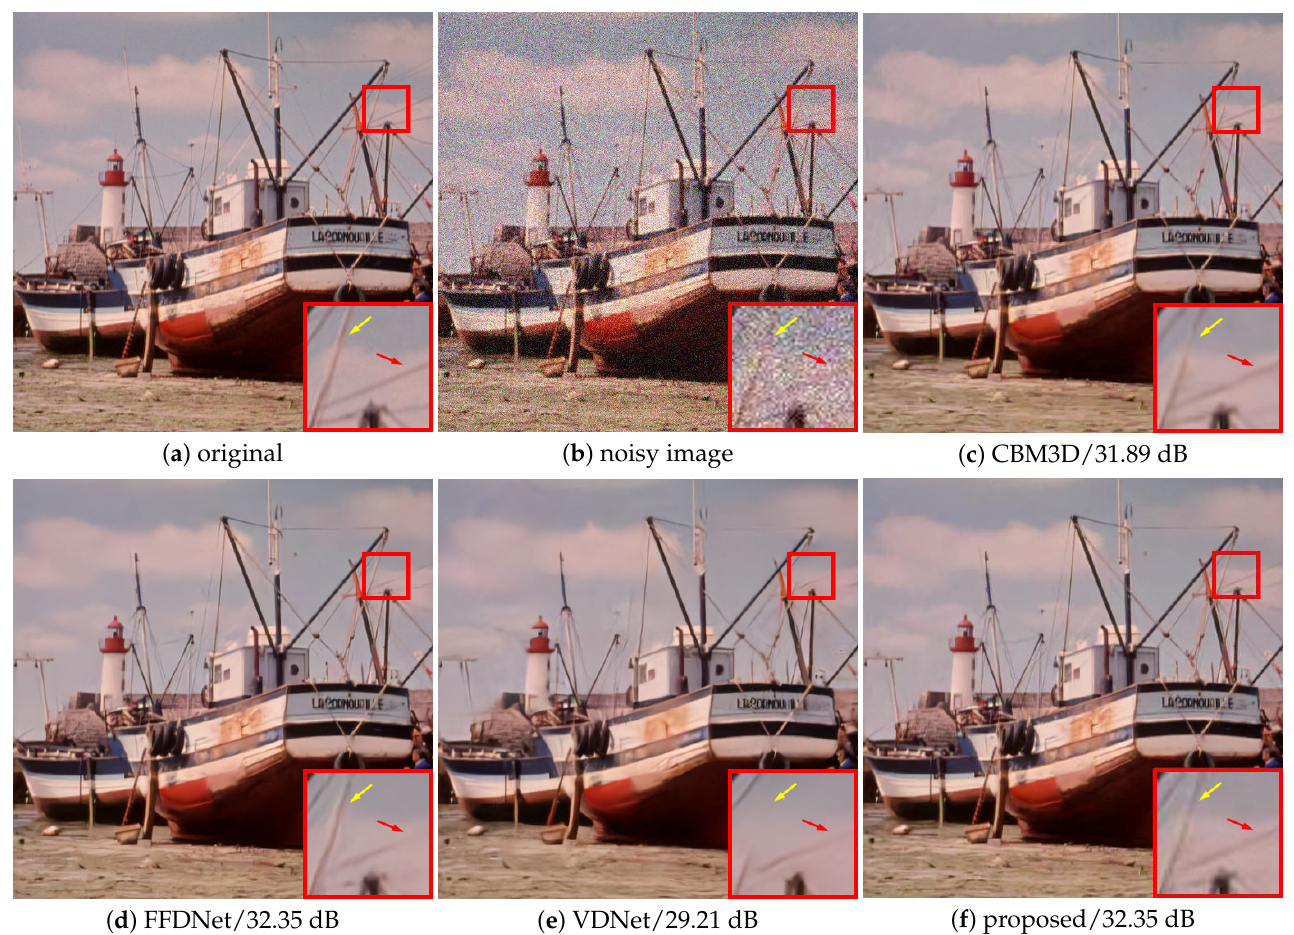
Figure 9. Denoising results of a color image with noise level σ =